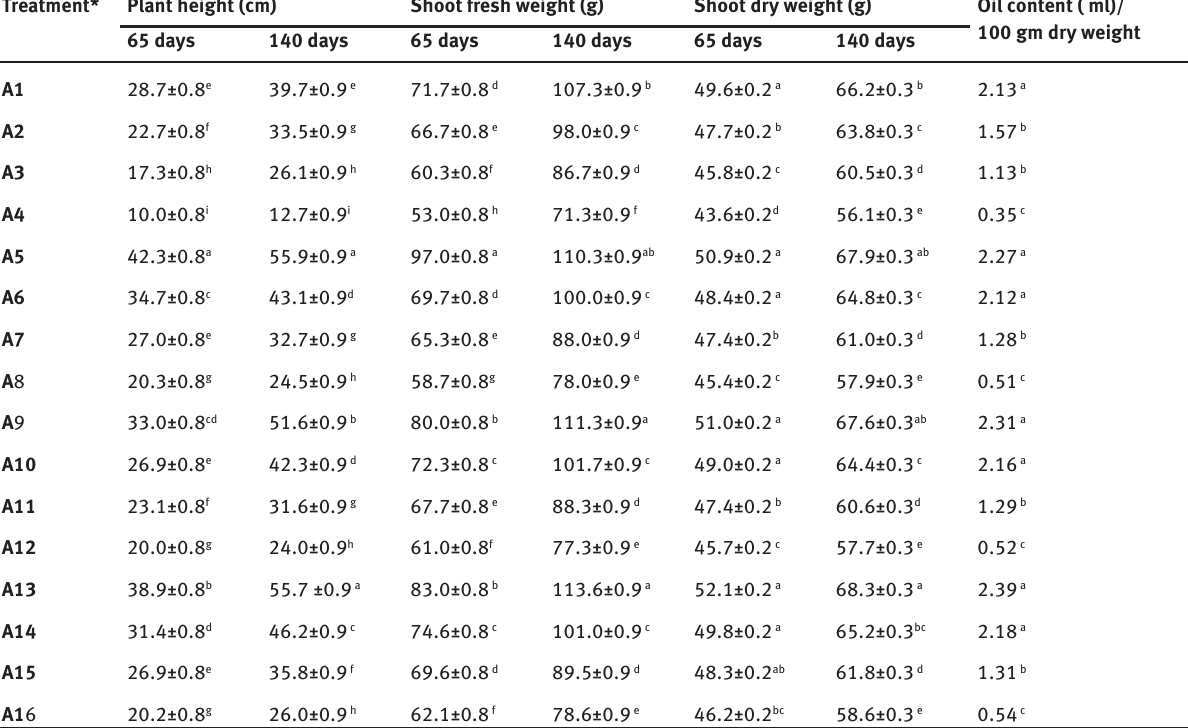
Table 6: Effect of bacterial inoculation of Bacillus licheniformis T11r and Bacillus velezensis T13r on the growth and oil content of T. vulgaris under different concentrations of mineral